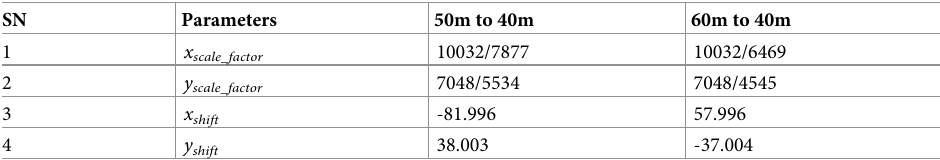
Table 7. The transform